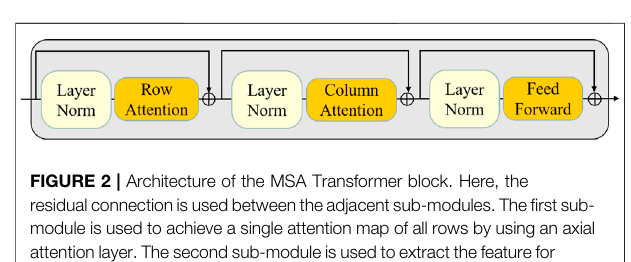
Frontiers in Materials |